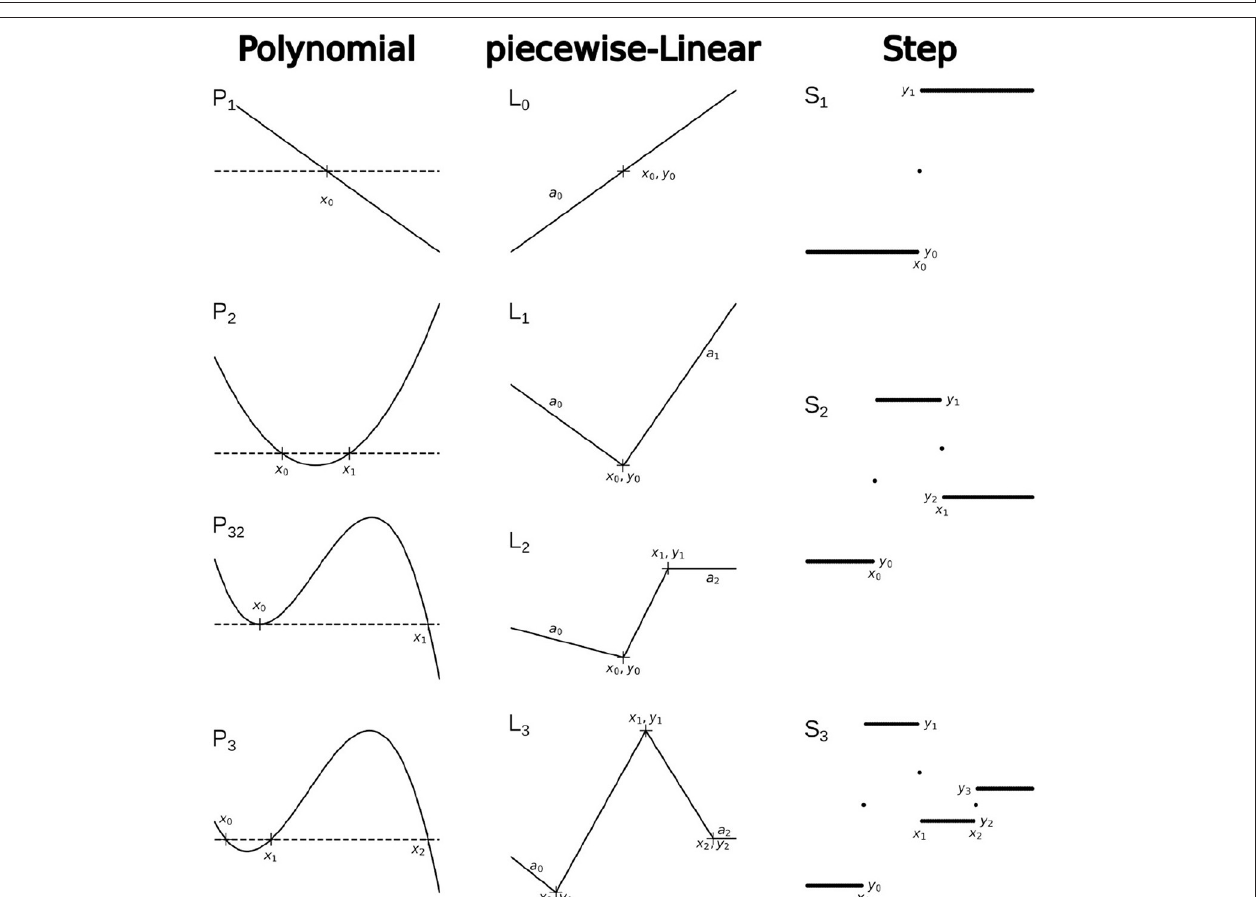
FIGURE 3 | Examples of functions, which comprise the